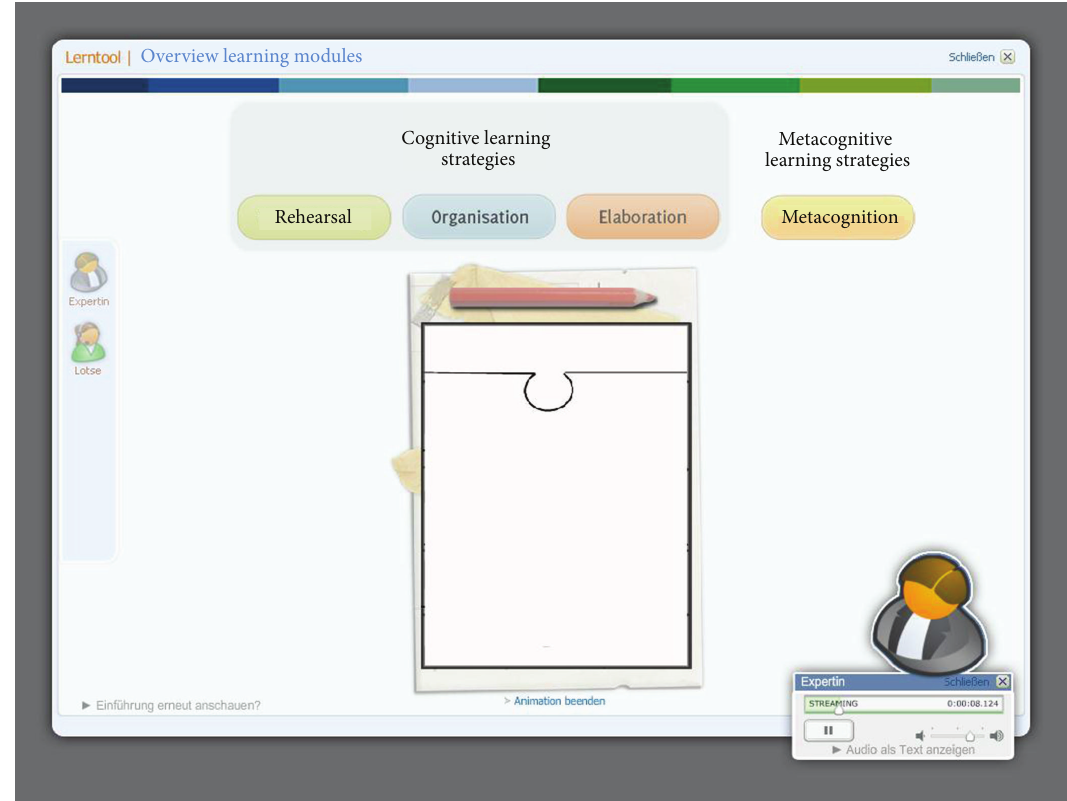
Figure 4: Example of the “modality principle.” Expert speaks (on the lower right) while related visual elements appear step by step (middle).